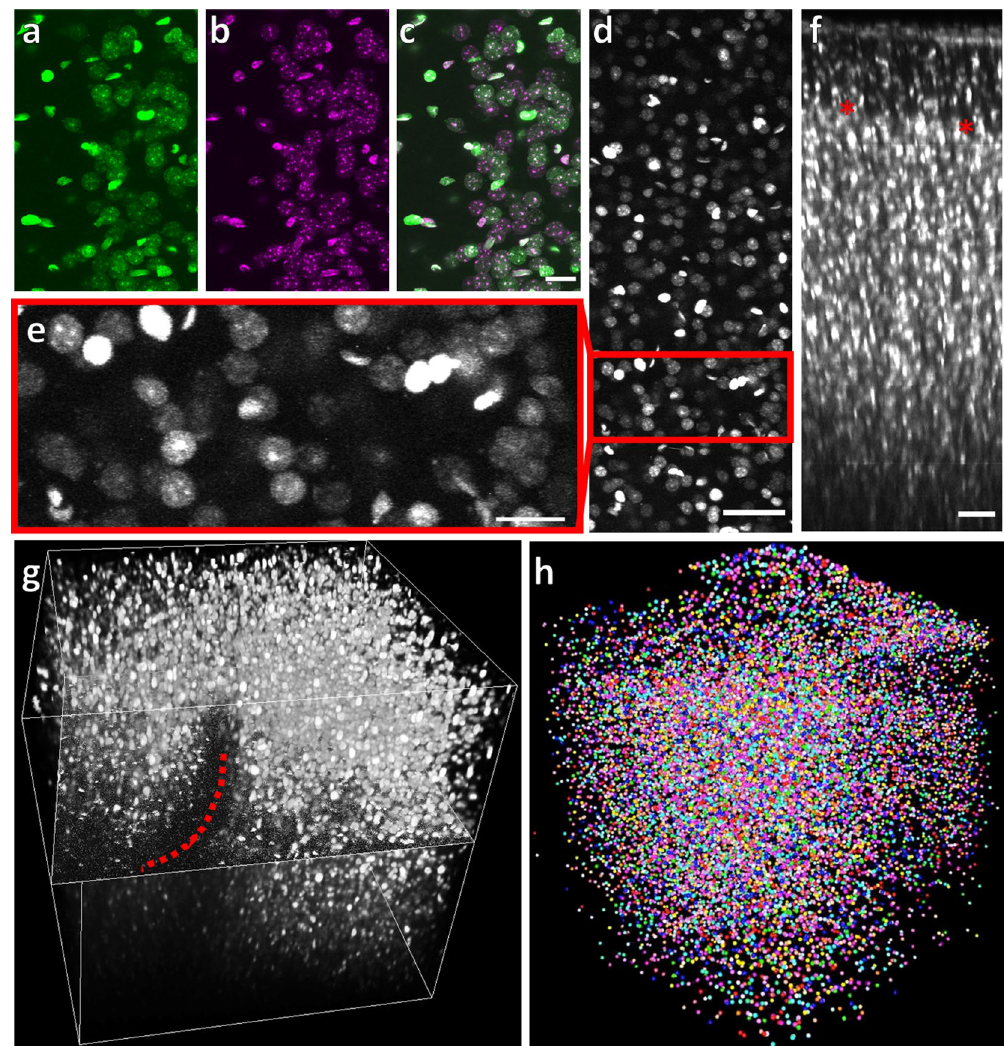
Figure 4. Histone-GFP labeled cell nuclei. ( a – c ) Confocal Microscopy of fixed brain slices of Histone-GFP mice shows that all DAPI-stained nuclei ( a ) are also labeled with Histone-GFP ( b ) as seen in the overlap ( c , green = Histone-GFP, magenta = DAPI). Scale bar = 10 µm. ( d ) Representative example image consisting of a maximum intensity projection of 10 consecutive image frames covering 20 µm of tissue recorded at a depth of 200 µm in Histone-GFP positive mice using 2Pii. Scale bar = 100 µm. ( e ) Close up of D. Scale bar = 20 µm. ( f ) Average intensity projection of a stack cropped in ZX. The surface of the brain is located at the top of the image. Red stars delineate the lower border of cortical layer 1 as visible in change of cell density. Scale bar = 50 µm. ( g ) A representative rendering of a 700 µm × 700 µm × 700 µm stack recorded by in vivo 2Pii in a Histone- GFP mouse. One orthogonal slice is displayed in the middle of the stack. The red stippled line denotes the ‘shadow’ cast by a blood vessel which strongly attenuates the laser beam. ( h ) Detected nuclei within a volume of 700 µm × 700 µm × 700 µm. Each sphere corresponds to the centroid position of a nucleus and is randomly